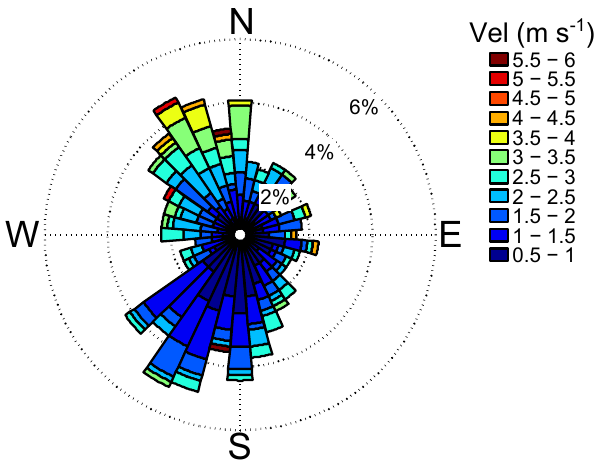
Figure 4. Wind rose from the sampling site during the SAMBBA campaign. Data from the National Institute of